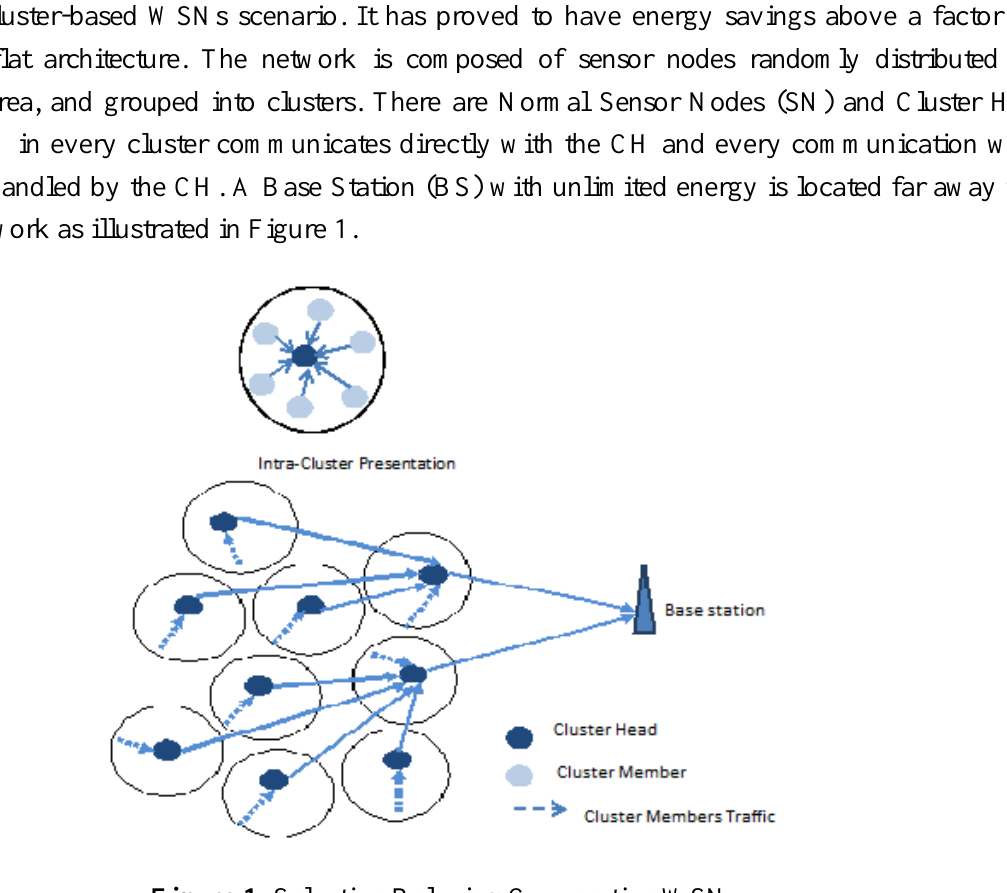
Figure 1. Selection Relaying Cooperative